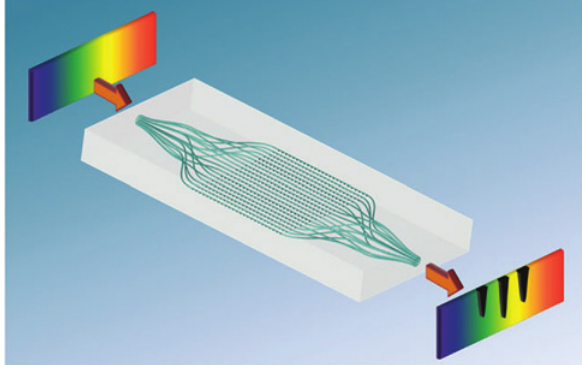
Figure 23: Narrowband spectral filtering of multimode light on a 3D integrated chip using photonic lanterns and